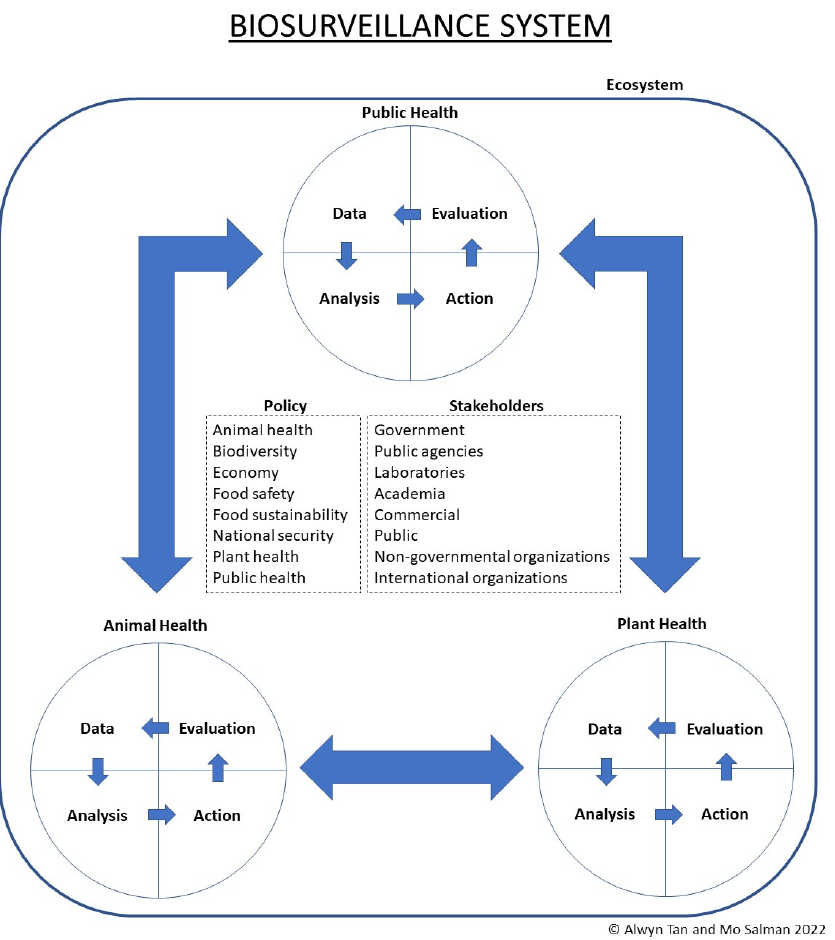
Figure 3. Components of a biosurveillance system under a One Health concept, showing the complementary relationships between components and One Health Sectors. Table 1. Comparison of definitions of biosurveillance and animal health surveillance